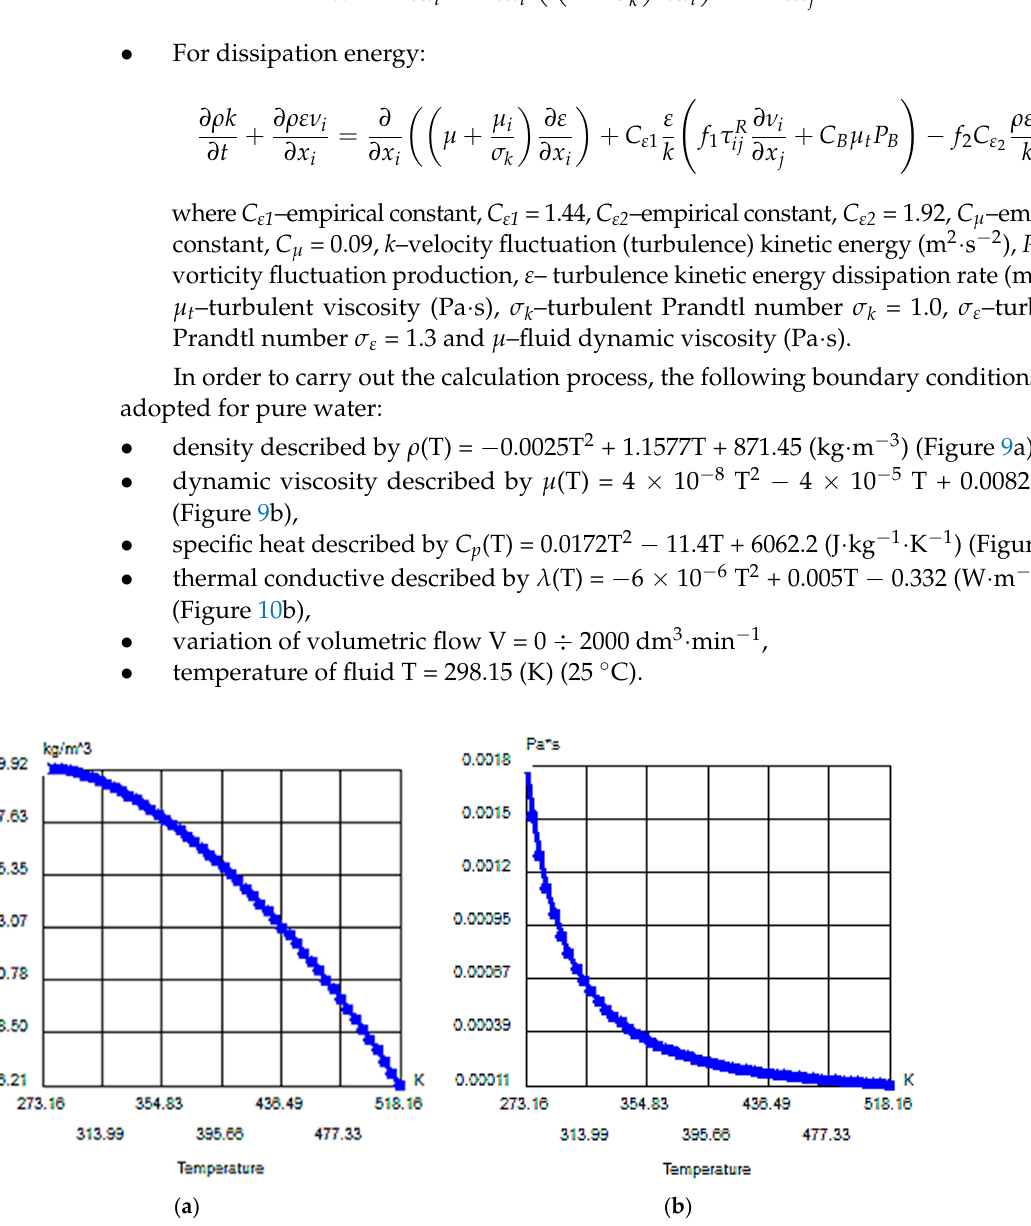
Figure 9. The variation curves of density ( ρ ) ( a ) and dynamic viscosity ( µ ) ( b ) of pure water depending on the temperature used in the CFD calculations.